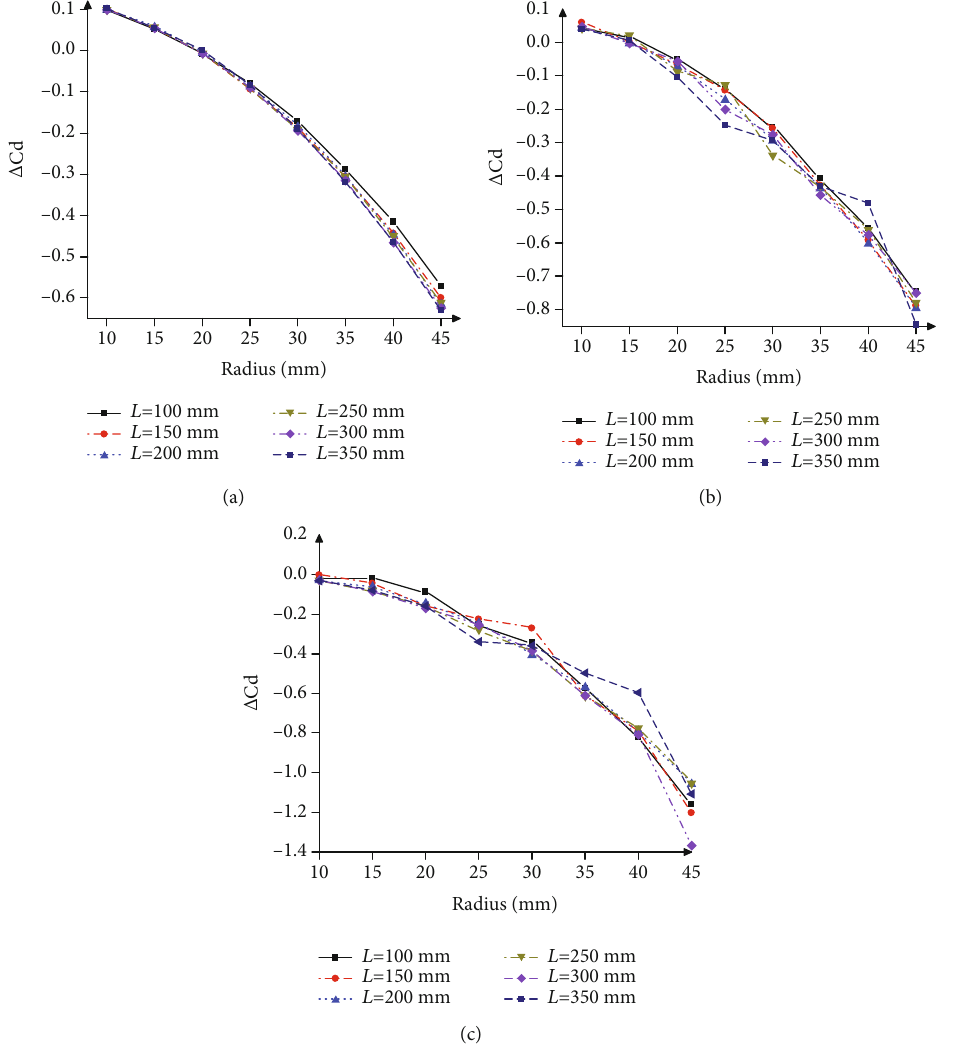
Figure 8: Drag reduction rate and radius of the aerodisk. (a) Ma 1.5, (b) Ma 2, and (c) Ma